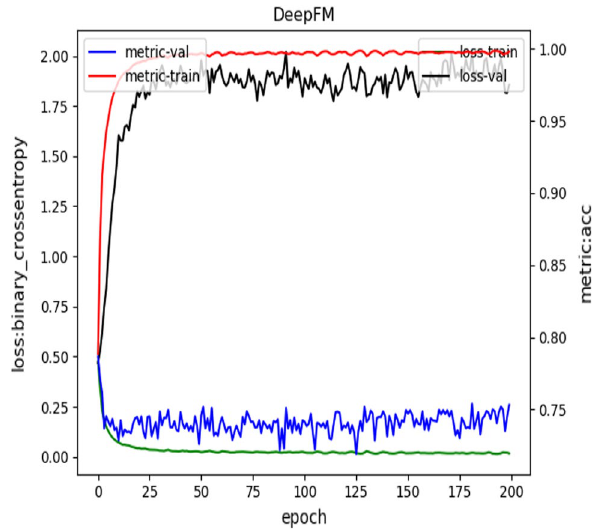
Fig. 8 AUC and Logloss of DeepFM algorithm